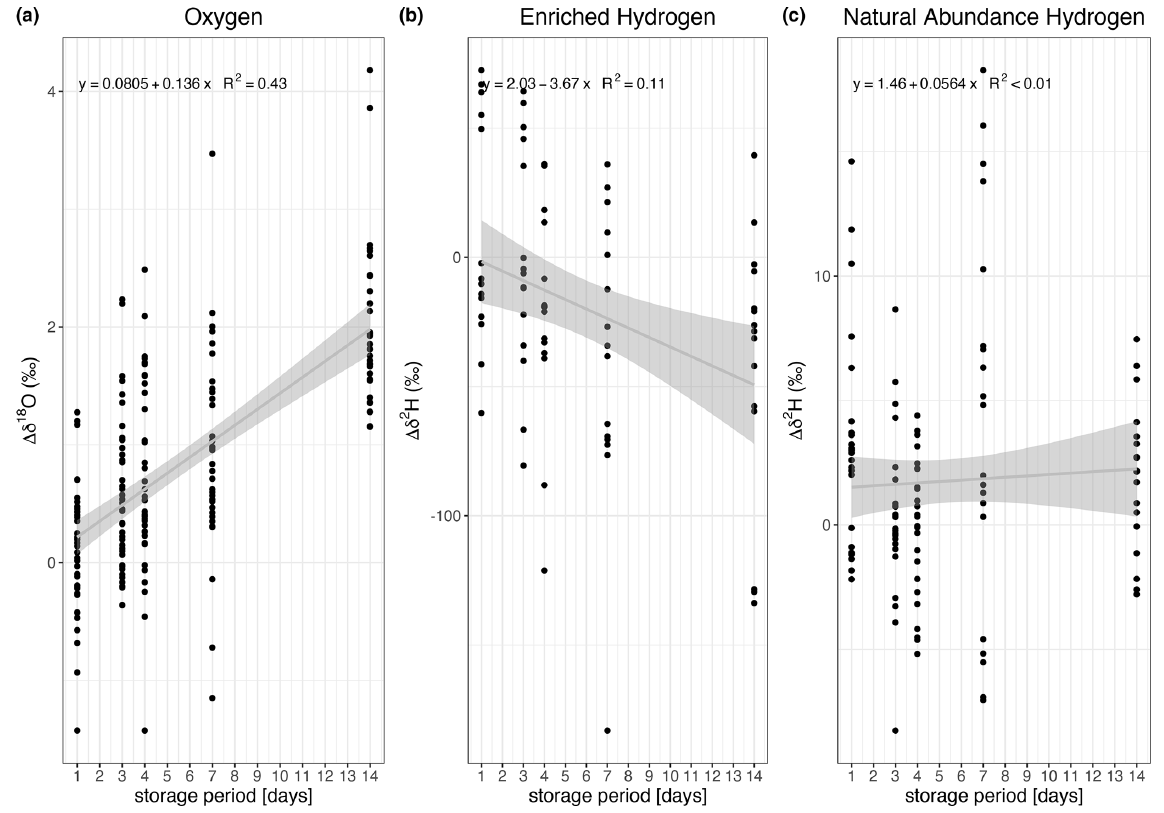
Figure 5. Linear regressions for the change ( (cid:49) ) in isotopic composition over the storage time. The analysis was conducted separately for δ 18 O (a) , δ 2 H ( b , for enriched in 2 H), and δ 2 H ( c , for natural abundance). The change in isotopic composition was significant for 18 O (see panel a for regression equations and R 2 ), and 2 H (panel b ) for the enriched sources. It was insignificant for 2 H change in the natural abundance sources (panel c